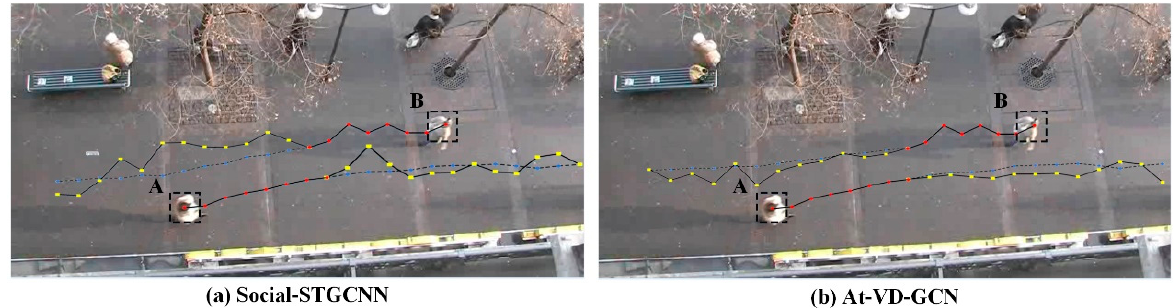
Figure 9. Comparison of the trajectory prediction of the model in this paper ( b ) with that of Social- STGCNN ( a ) in Hotel, where red dots indicate the observed location, blue dashed lines indicate the future real location, and yellow square dots indicate the predicted location based on the algorithm.